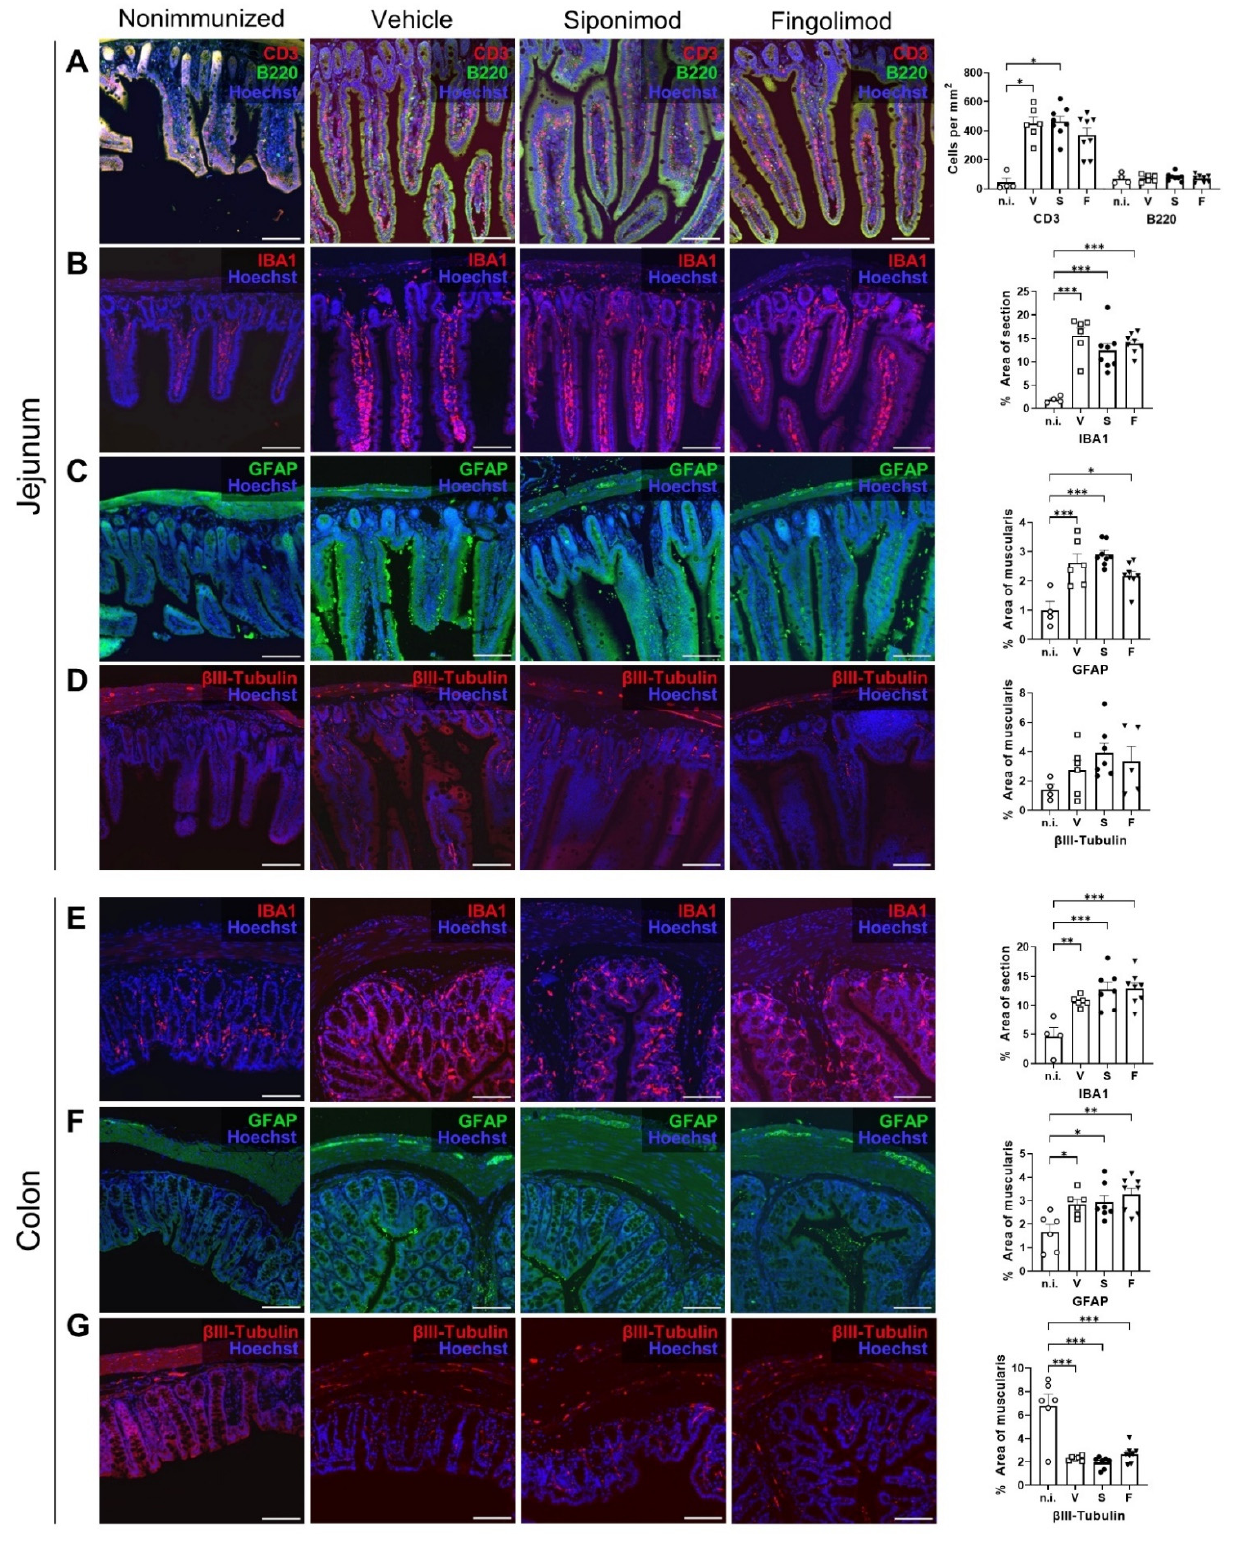
Figure 4. Immunohistochemical (IHC) staining of the jejunum and colon in siponimod- or fingolimod-treated experimental autoimmune encephalomyelitis (EAE) mice. IHC staining of ( A – D ) jejunum and ( E – G ) colon from nonimmunized (n.i.) versus chronic EAE mice treated with siponimod (S), fingolimod (F), or vehicle (V) and corresponding quantitative analysis. ( A ) Lamina propria infiltrating B and T cells were counted. ( B , E ) IBA1 + area was measured and compared with whole section